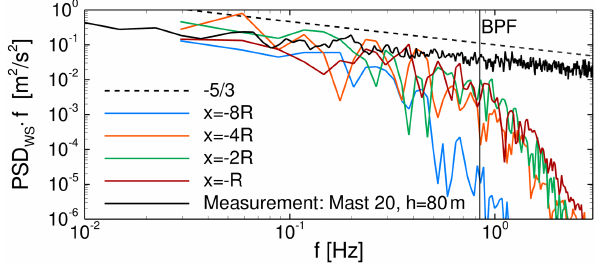
Figure 9. Development of power spectral density of horizontal wind speed upwind of the turbine at 77ma.g.l. in FLOWer.